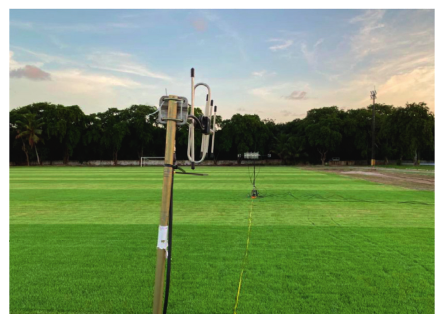
Figure 14: Receiver system.